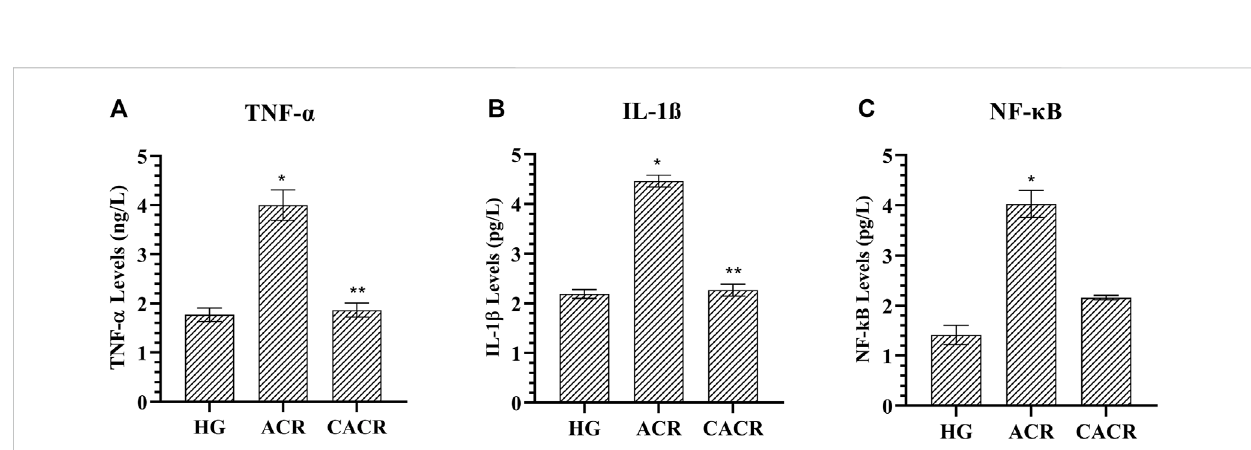
FIGURE 3 (A – C) AnalysisofTNF- α , IL-1 β andNF- κ Blevelsinlivertissuesofratsinexperimentalgroups.n=6/eachgroup. Thebarsshowthemean±standard deviation. * p < 0.05, ACR group is compared with the HG and CACR groups. ** p > 0.05, CACR group is compared with the HG